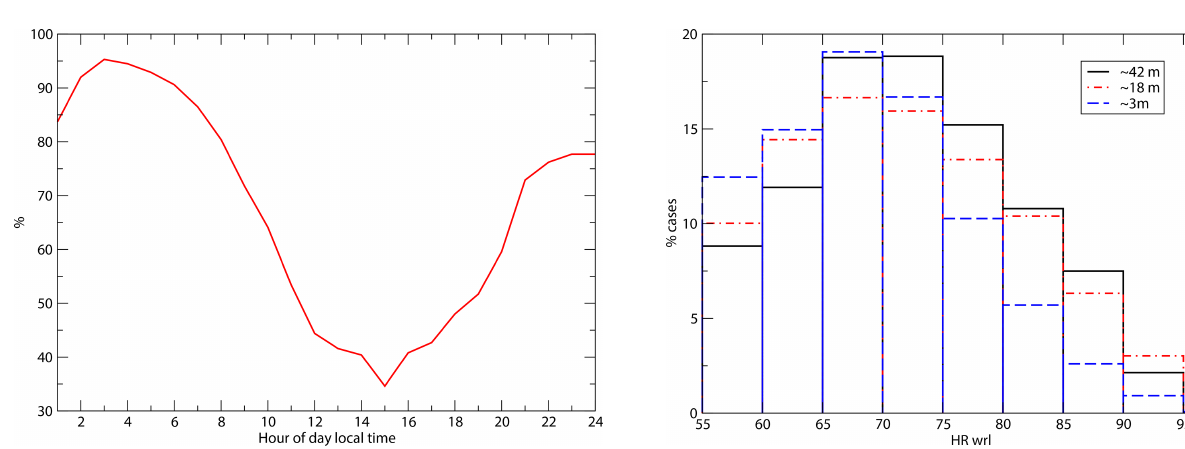
Figure 11. Hourly frequency of cases with an upward vertical gra- dient of PPW, implying downward turbulent moisture flux in De- cember and January (austral summer) for the period from 2018 to